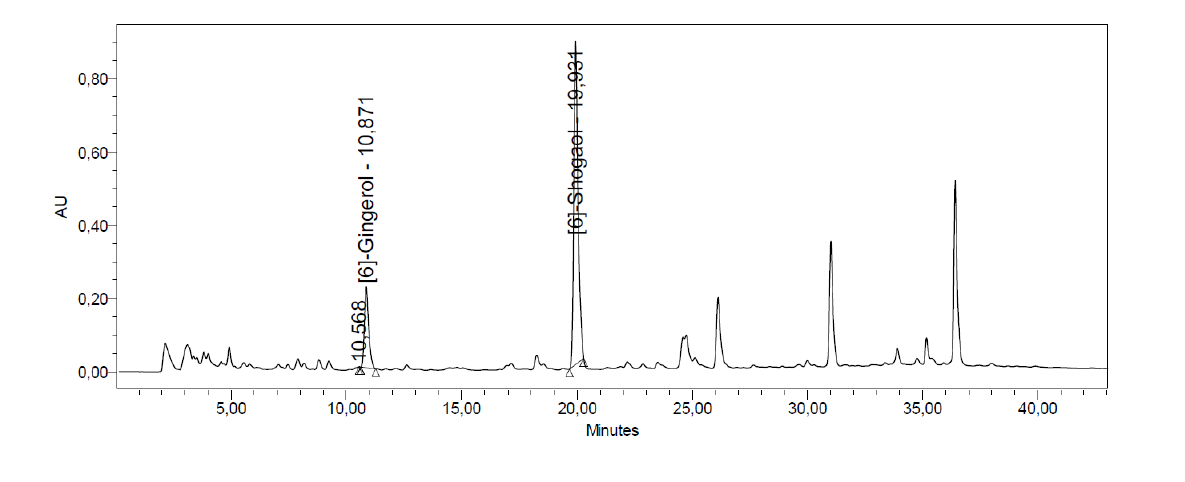
Fig. 4. The second food supplement„s (FS_2) chromatogram